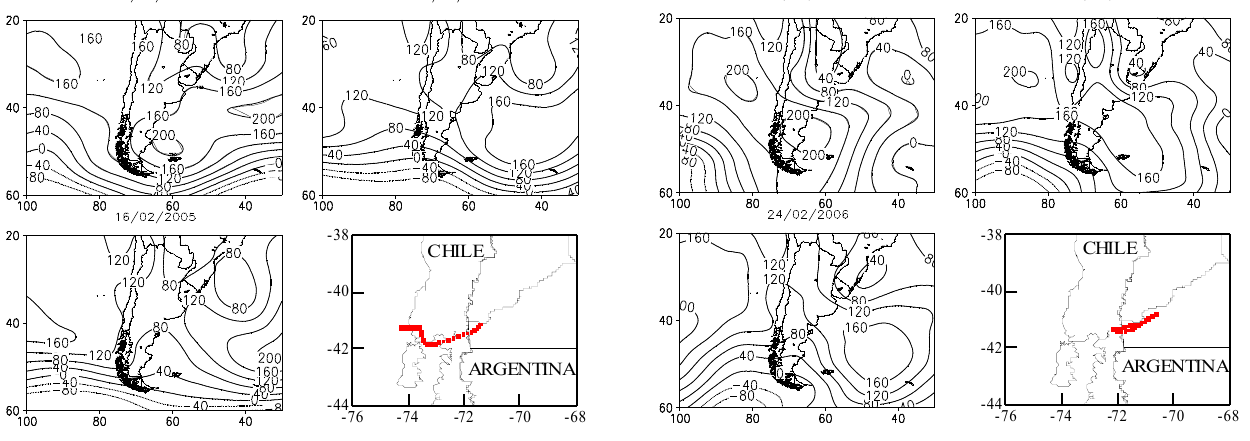
Fig. 5. Daily mean geopotential height fields of 1000hPa pressure surface for the day of Weinmannia pollen capture and 48h before. Bottom right panel: 48h backward trajectory started at 24:00hlocal time 24 February 2006 in San Carlos de